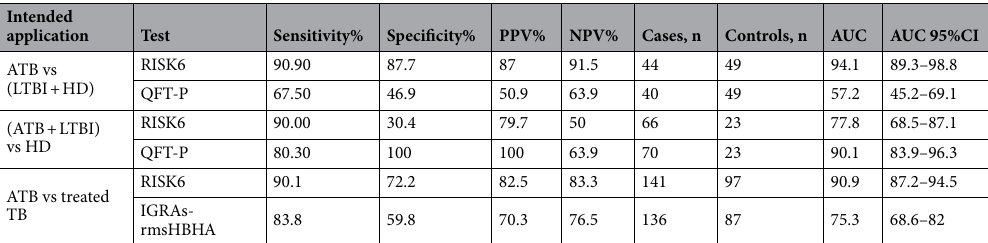
Table 3. Performance of RISK6 signature compared to Interferon-γ release assays: QuantiFERON-TB Gold Plus (QFT-P) and recombinant Mtb -HBHA expressed in Mycobacterium smegmatis (IGRAs-rmsHBHA). ATB